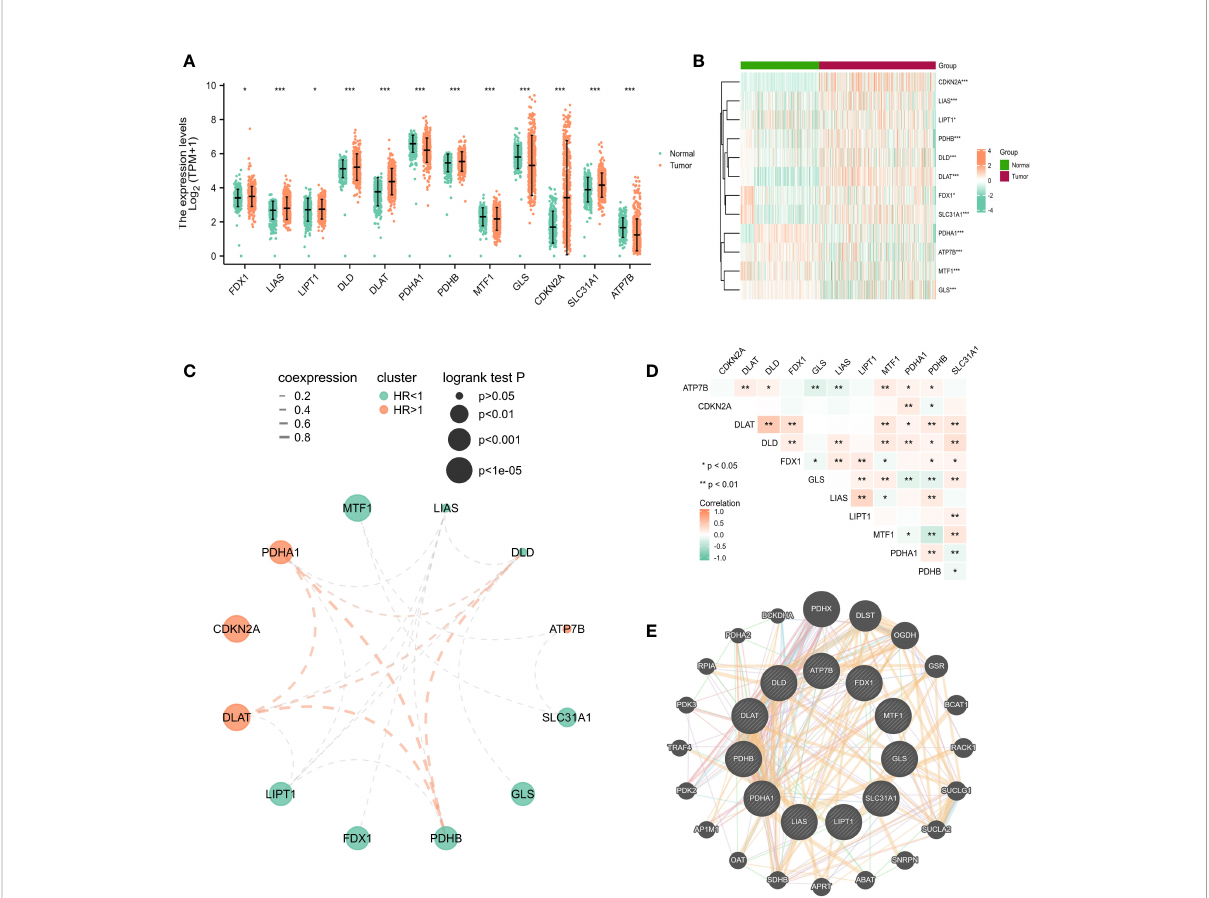
FIGURE 1 The expression of cuproptosis-related genes in LUAD patients and their prognostic value. Box plots (A) and heatmap (B) of cuproptosis-related genes in LUAD when compared to normal tissues (with green and red signifying low and high expression levels, respectively). (C) Spearman correlation and prognostic values of cuproptosis-related genes in LUAD patients. Red represents HR>1 whereas green represents HR<1. The larger the circle, the smaller the log-rank p . (D) Correlation analysis between cuproptosis-related genes in LUAD patients. (E) Protein-protein interactions among the cuproptosis-associated genes. The bigger the circle is, the most important gene it might be. * P <0.05, ** P <0.01, *** P